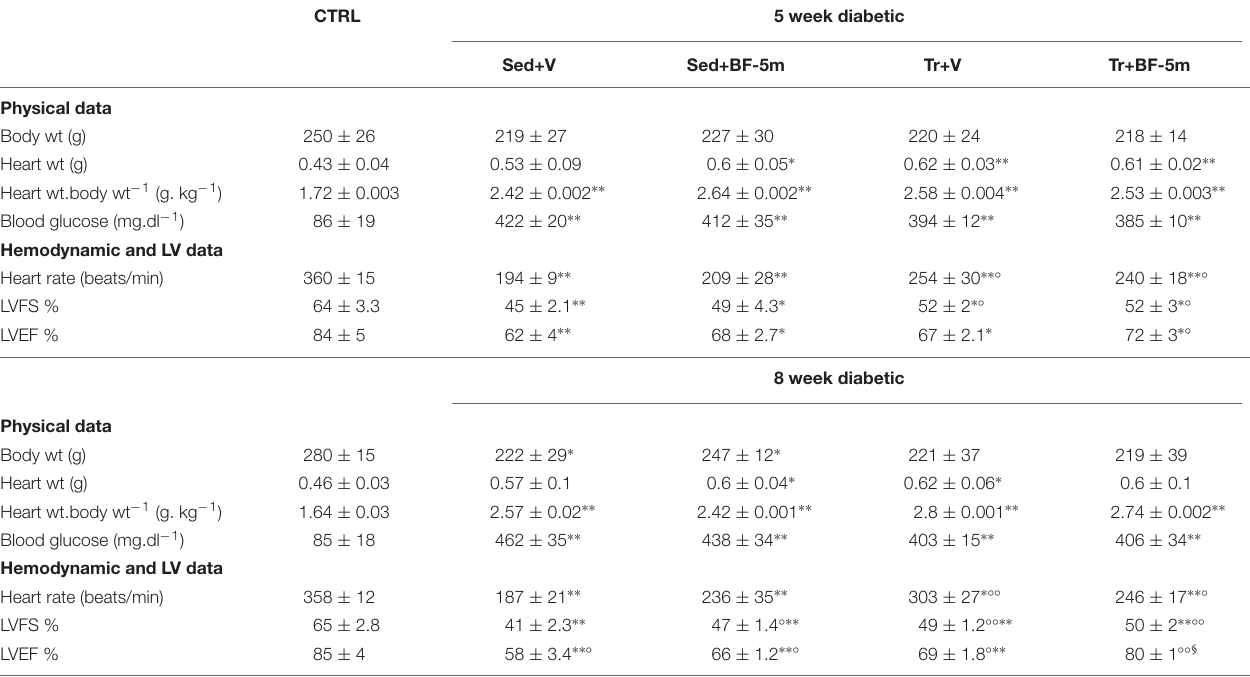
TABLE 1 | Physical and cardiac parameters of diabetic rats after 5 and 8 weeks observation. CTRL 5 week diabetic